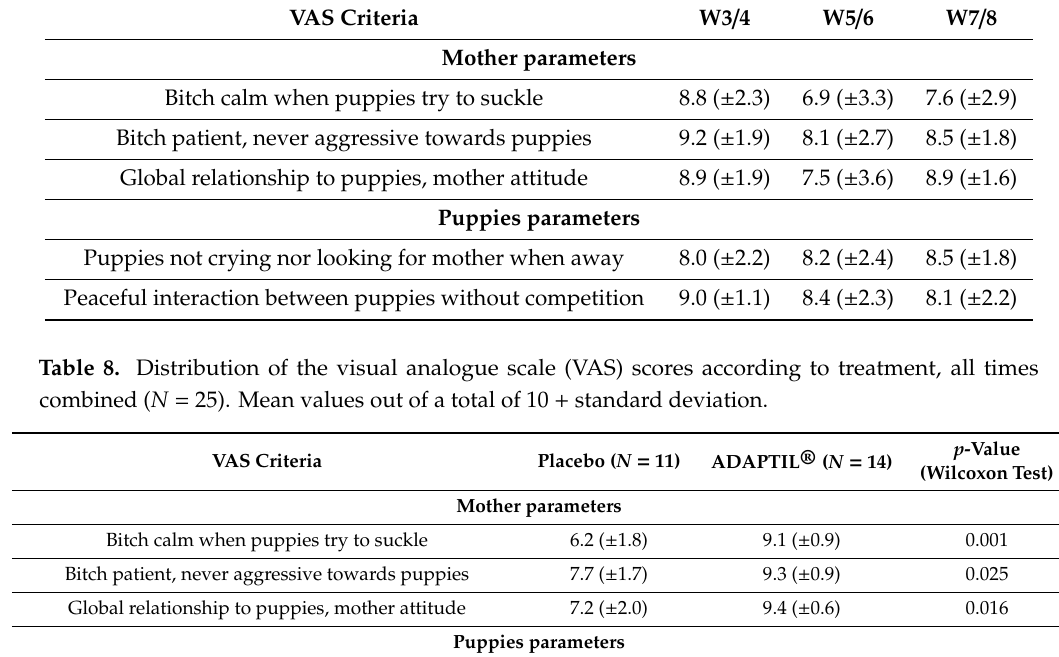
Table7. Distributionofthevisualanaloguescale(VAS)scoresassessingbitchesandpuppies’interactions according to time point ( N = 25). Mean values out of a total of 10 + standard deviation.